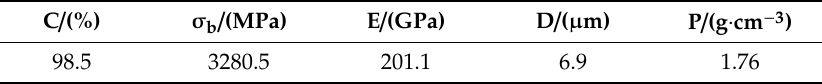
Table 2. Properties of Polyacrylonitrile (PAN)-Based